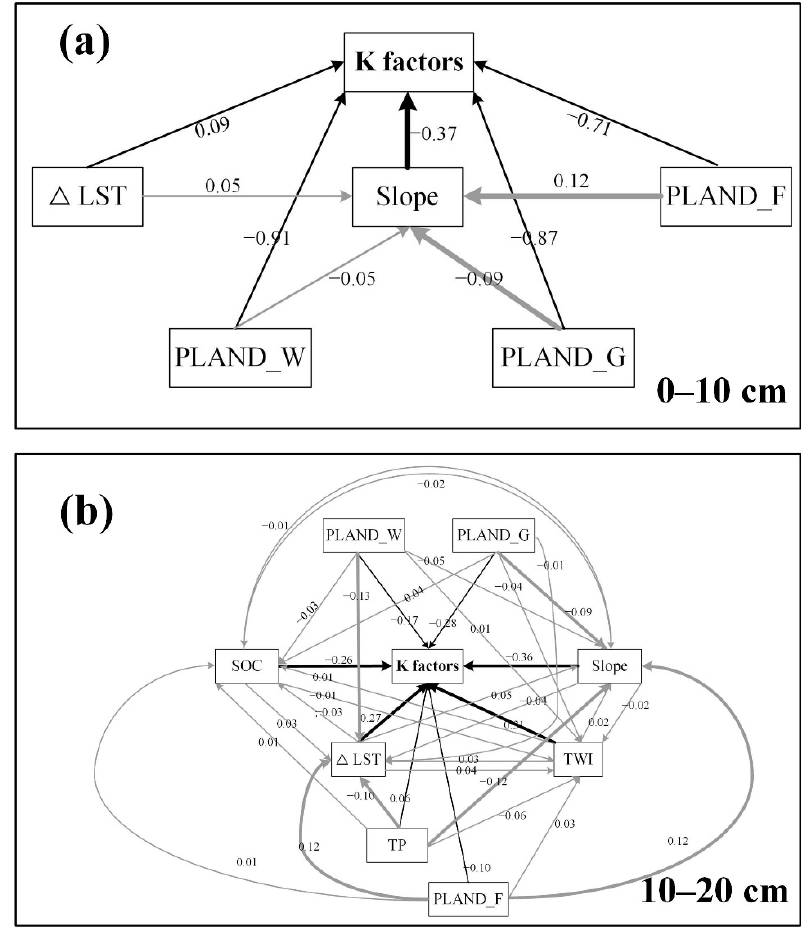
Figure 6. Path analysis results on the direct and indirect effects of soil, nature, and land use on K factors at 0–10 cm ( a ) and 10–20 cm ( b ) in the Zhifanggou watershed. Numbers show the path coefficients. Black and grey paths indicate direct and indirect effects, respectively. Thick lines indicate significant relationships ( p < 0.05), and the fine lines indicate non-significant relationships. TP, total porosity; SOC, soil organic carbon; Δ LST: the land surface temperature difference between seasons; TWI: topographic wetness index; PLAND_F, PLAND_W, and PLAND_G: the proportion of the landscape occupied by farmland, woodland, and grassland, respectively. K factors: soil erodibility factor.